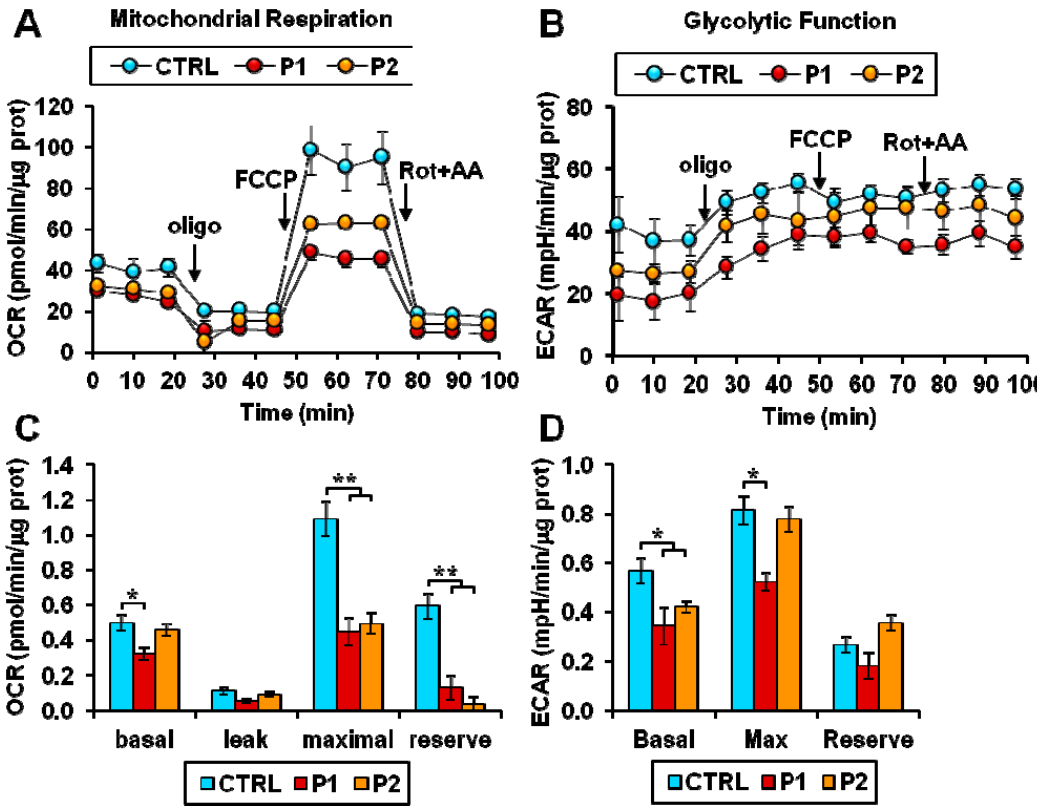
Figure 2. Energy metabolism in patient fibroblasts with the parkin mutation. ( A , B ). Representative Seahorse XF trace of OCR ( A ) and ECAR ( B ) performed in normal (CTRL) and Parkinson’s disease (PD) patient (P1, P2) fibroblasts. For each trace, after a baseline reading, oligomycin A (oligo), FCCP, and rotenone + antimycin A (Rot + AA) were added as indicated by the arrows. See Materials and Methods for experimental details. ( C , D ) The bar graphs display the data obtained from experiments shown in ( A , B ). ( C ) Basal: resting OCR; leak: OCR measured in the presence of oligomycin; maximal: OCR measured in the presence of FCCP; reserve: di ff erence between maximal and basal respiration. The OCR values were corrected for the residual OCR measured in the presence of rotenone and antimycin A. ( D ) Basal: resting ECAR; Max: ECAR measured in the presence of oligomycin and FCCP; Reserve: di ff erence between maximal and basal glycolysis. Data show the mean ± SEM of four independent experiments performed in triplicate. Significance was calculated with the Student’s t -test; * p < 0.01, ** p < 0.005 vs. CTRL cells.